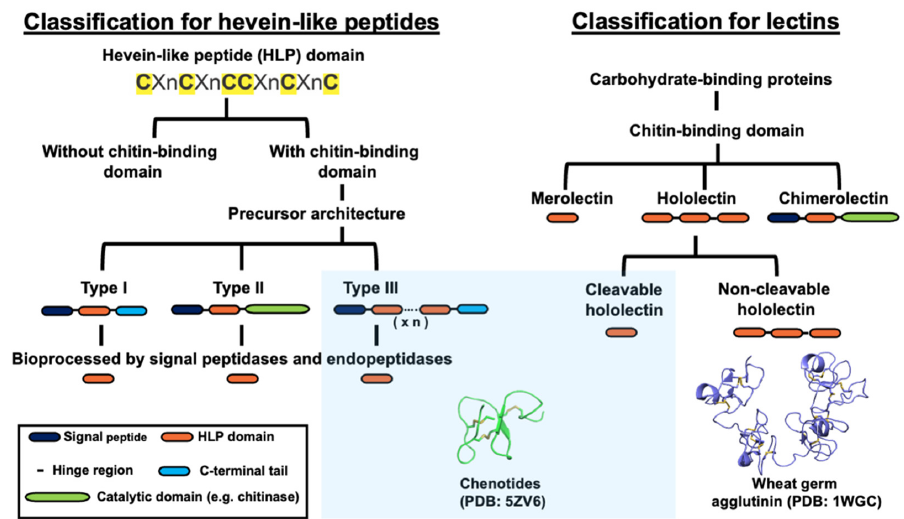
Figure 8. Classification of hevein-like peptides and lectins. Chenotides belongs to the family of chitin-binding hevein-like peptides with type III precursor architecture, as well as the family of cleavable hololectin. x n represents number of CB-HLP domain.